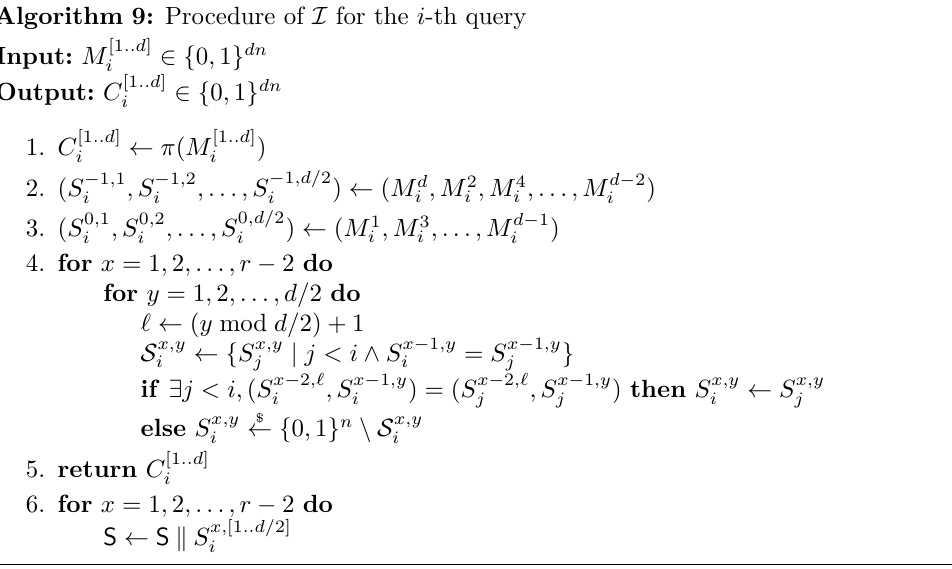
Algorithm 10: Procedure of I − 1 for the i -th query